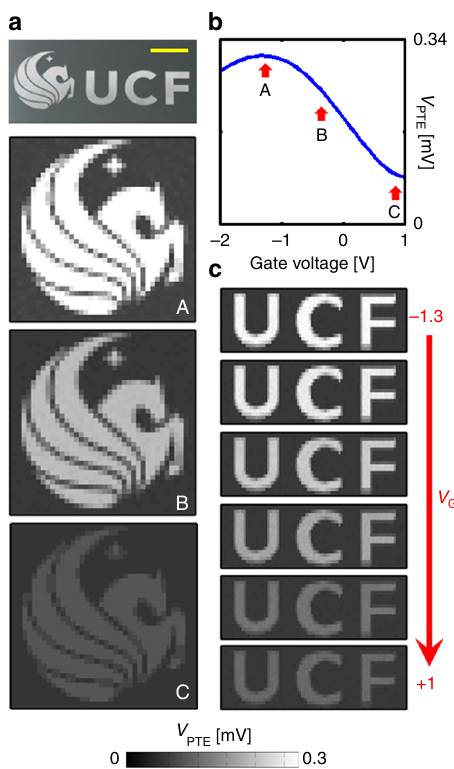
Fig. 4 Infrared imaging. The single-pixel imaging results, a , c for different gate voltages. The contrasts of the images scale according to the photo- thermoelectric voltage as a function of gate voltage, b . Figure ( a -top) is the object used for imaging. The yellow scale bar shows 5